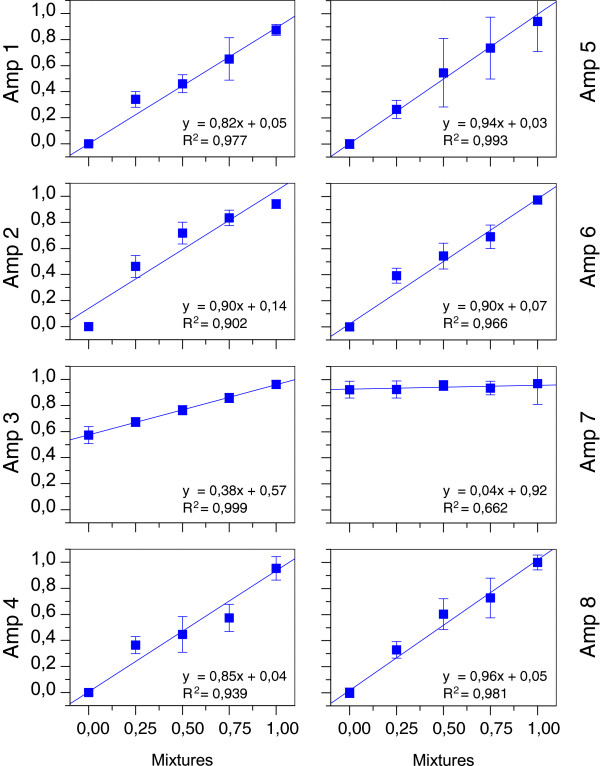
Amplicon calibration curves. Methylation of the artificial DNA mixtures is shown on the x-axis, and the experimentally determined methylation value for each amplicon is shown on the y-axis. Both values are given as a percentage of fully methylated DNA.